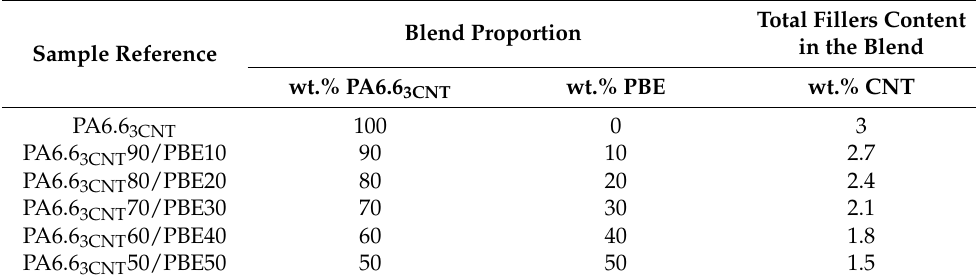
Table 1. Summary of the different extruded monofilaments.